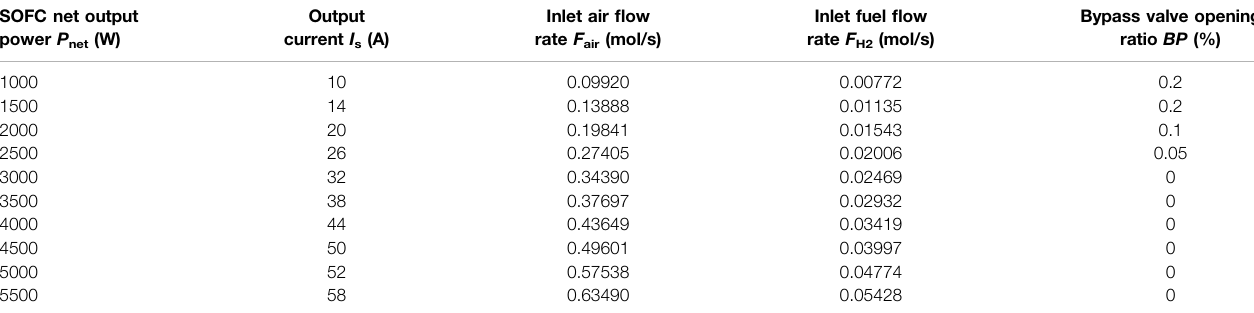
TABLE 1 | OOPs of the SOFC stand-alone